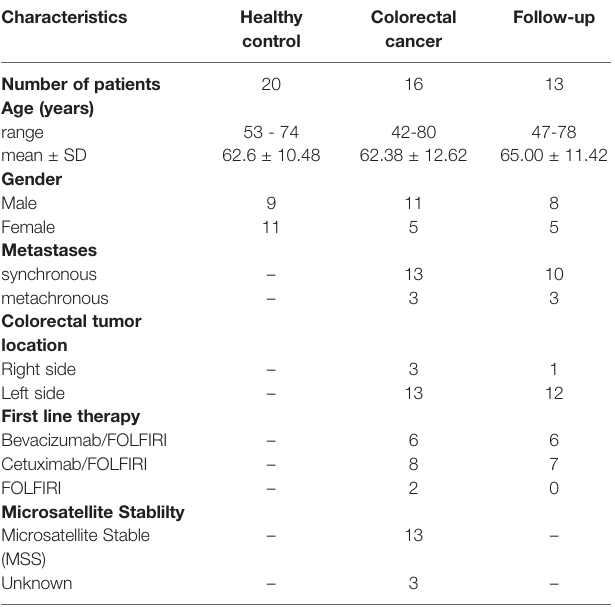
TABLE 1 | Characteristics of subjects in healthy and colon cancer